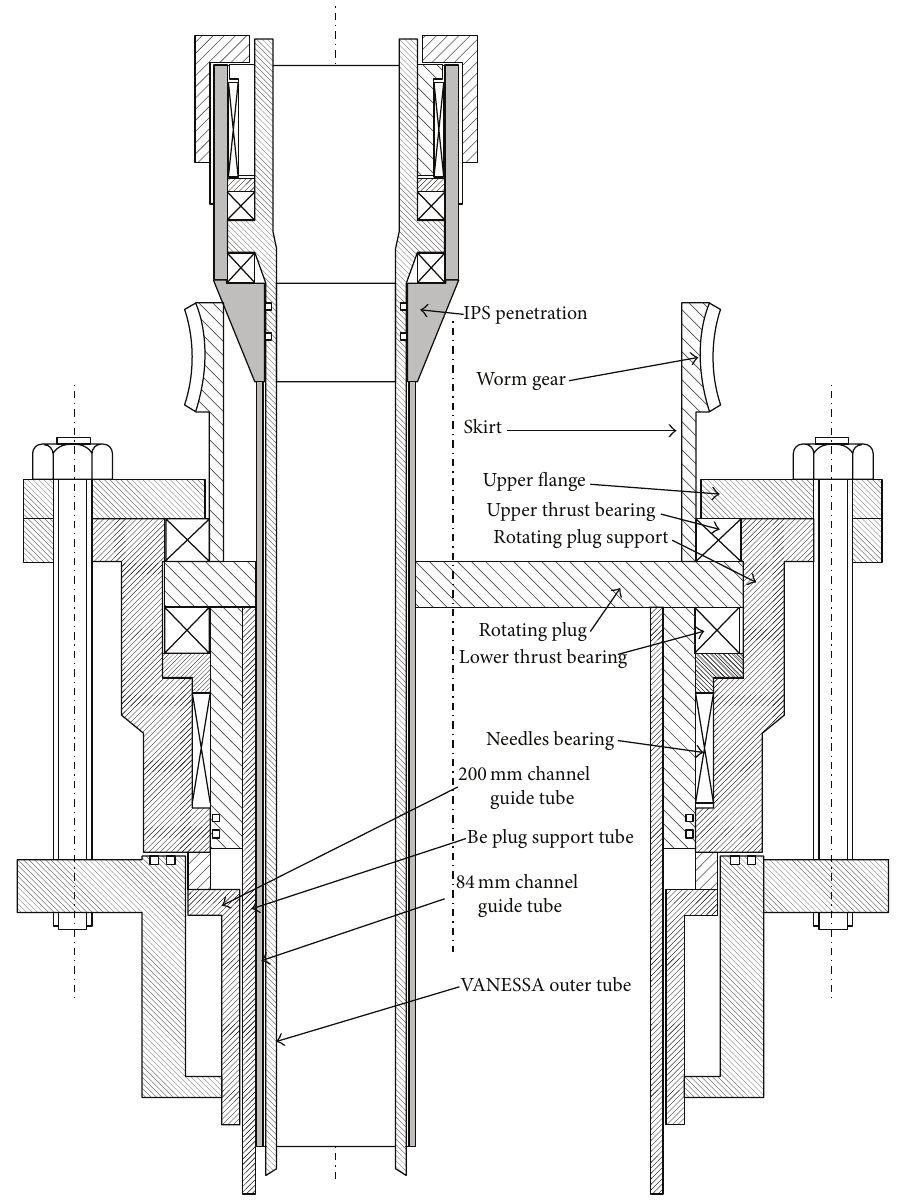
Figure 31: RODEO rotating plug at BR2